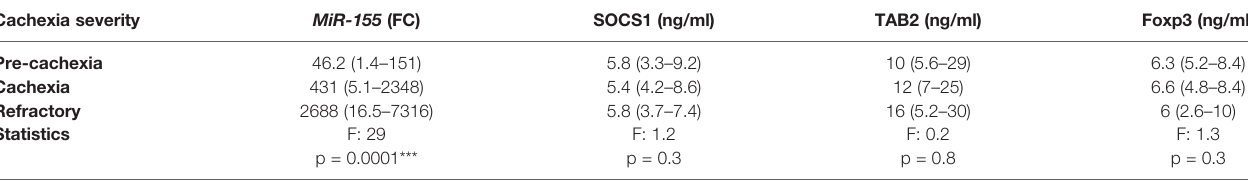
TABLE 7 | Expression level of miR-155, SOCS1, TAB2, and Foxp3 in cancer cachectic patients considering the cachexia severity, regardless of the cancer type. Cachexia severity MiR-155